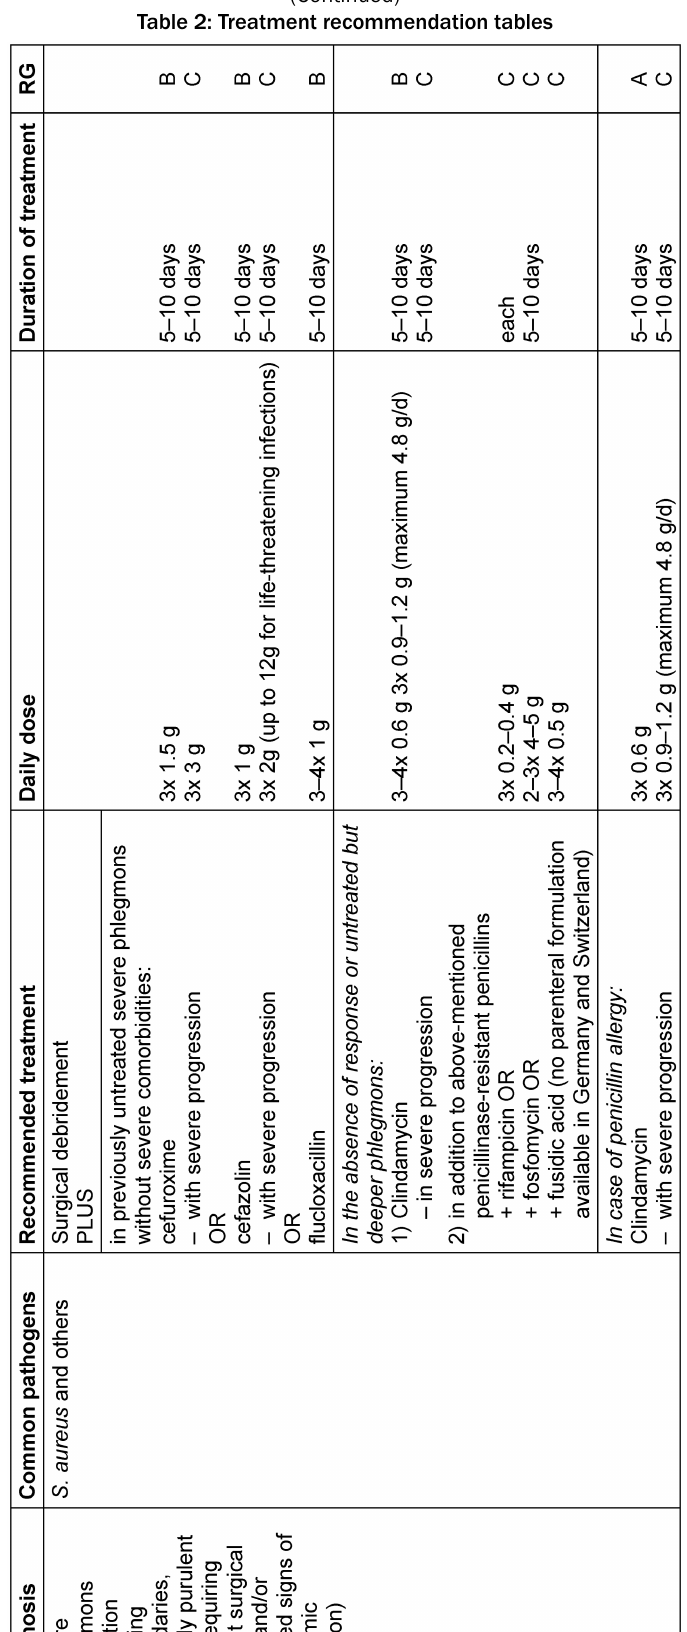
Table 2: Treatment recommendation